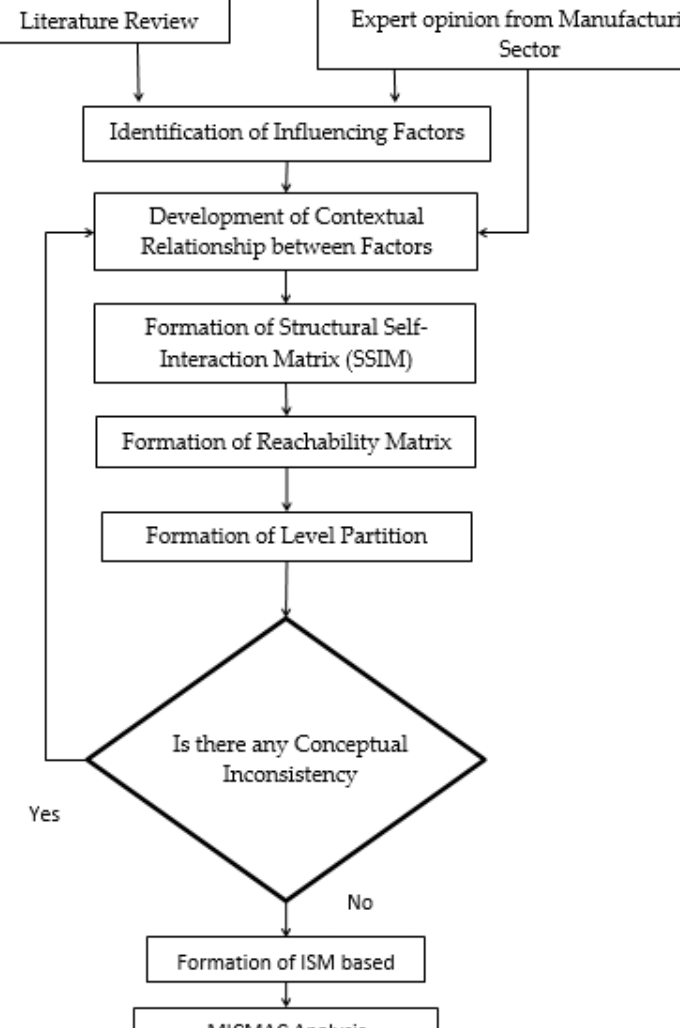
Figure 1. Solution Figure 1. Solution methodology.